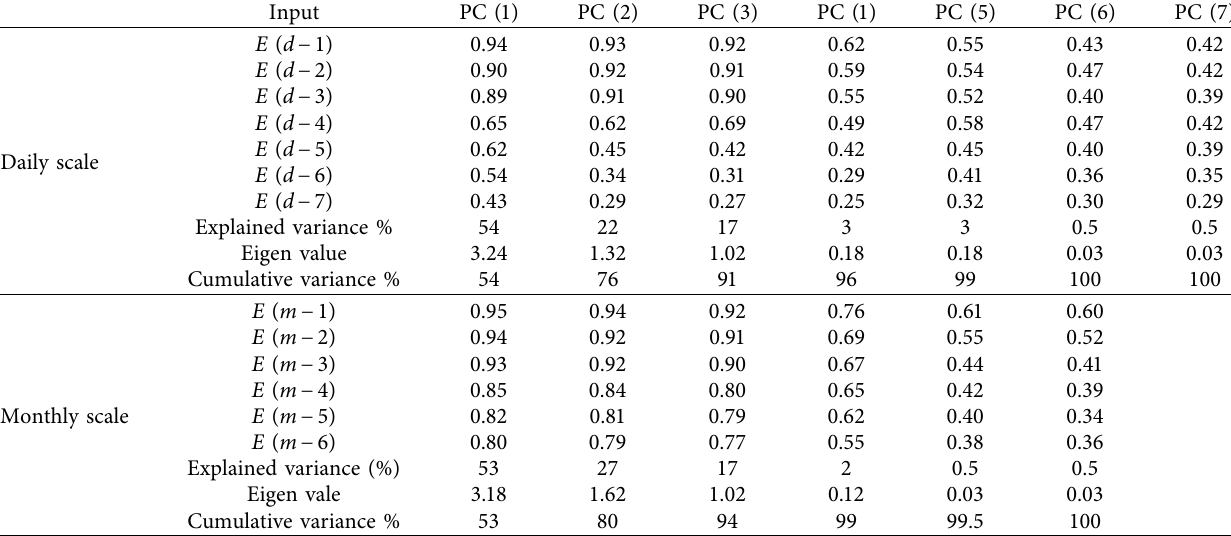
Table 2: The daily scale of outputs in the PCA.